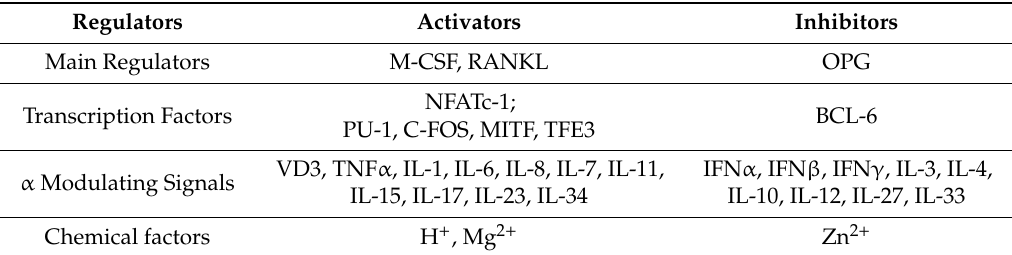
Table 1. Regulators of osteoclastogenesis. Table summarizing the main regulators of osteoclast di ff erentiation classified as activators or inhibitors. IL: interleukin; TNF: tumour necrosis factor; IFN: interferon; OPG: